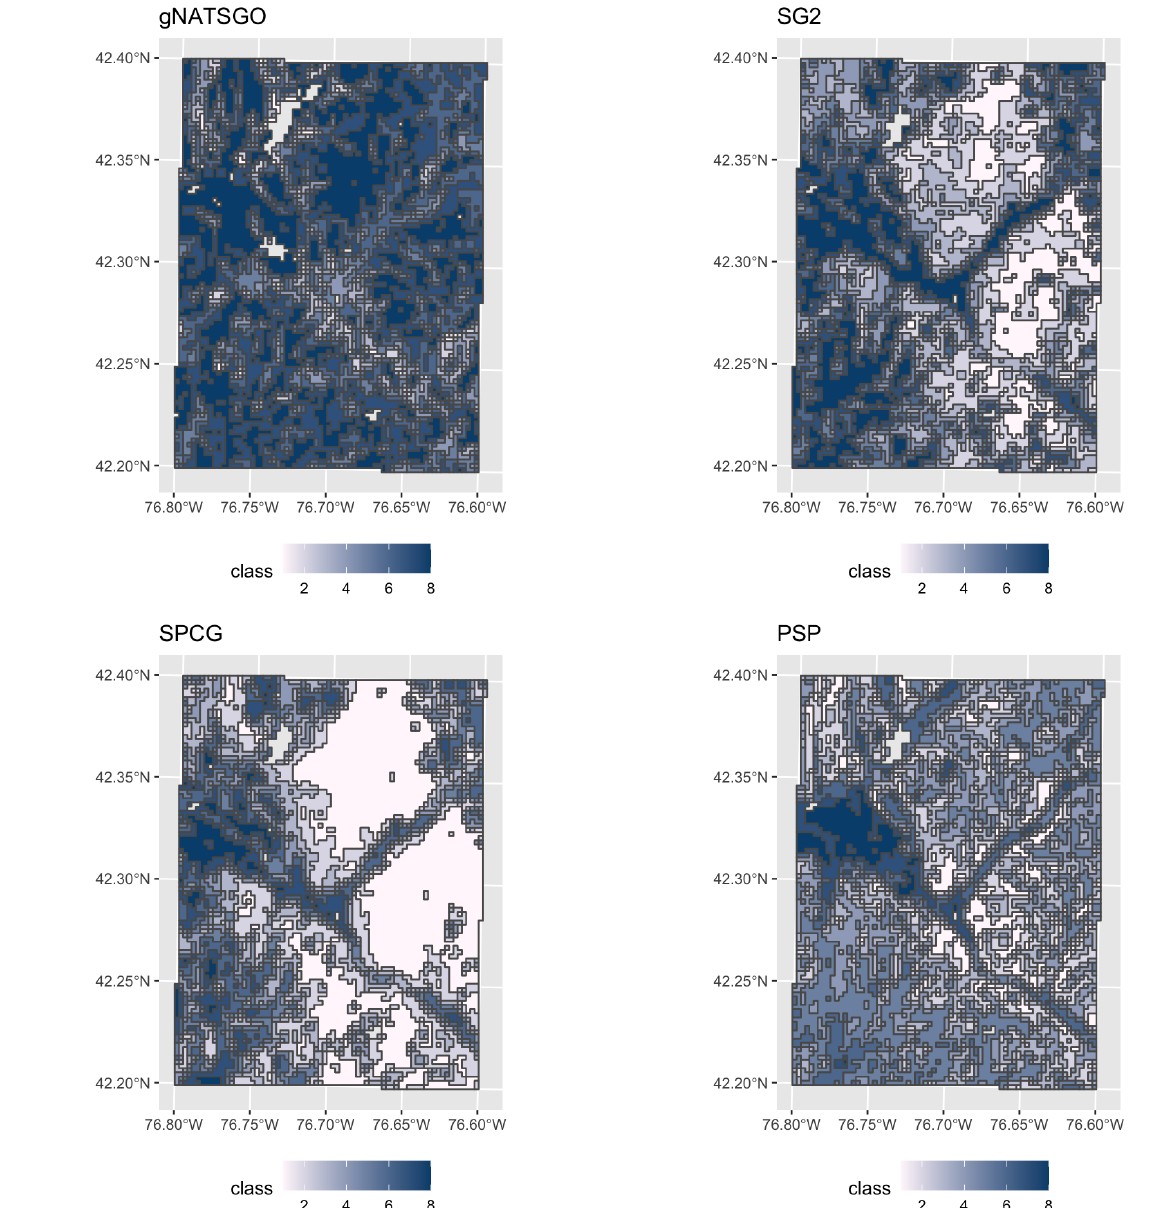
Figure 15. pH classes at 0–5cm and central NY in detail. Most areas of gNATSGO are in higher pH classes. PSP has the finest spatial pattern due to the DSMART disaggregation